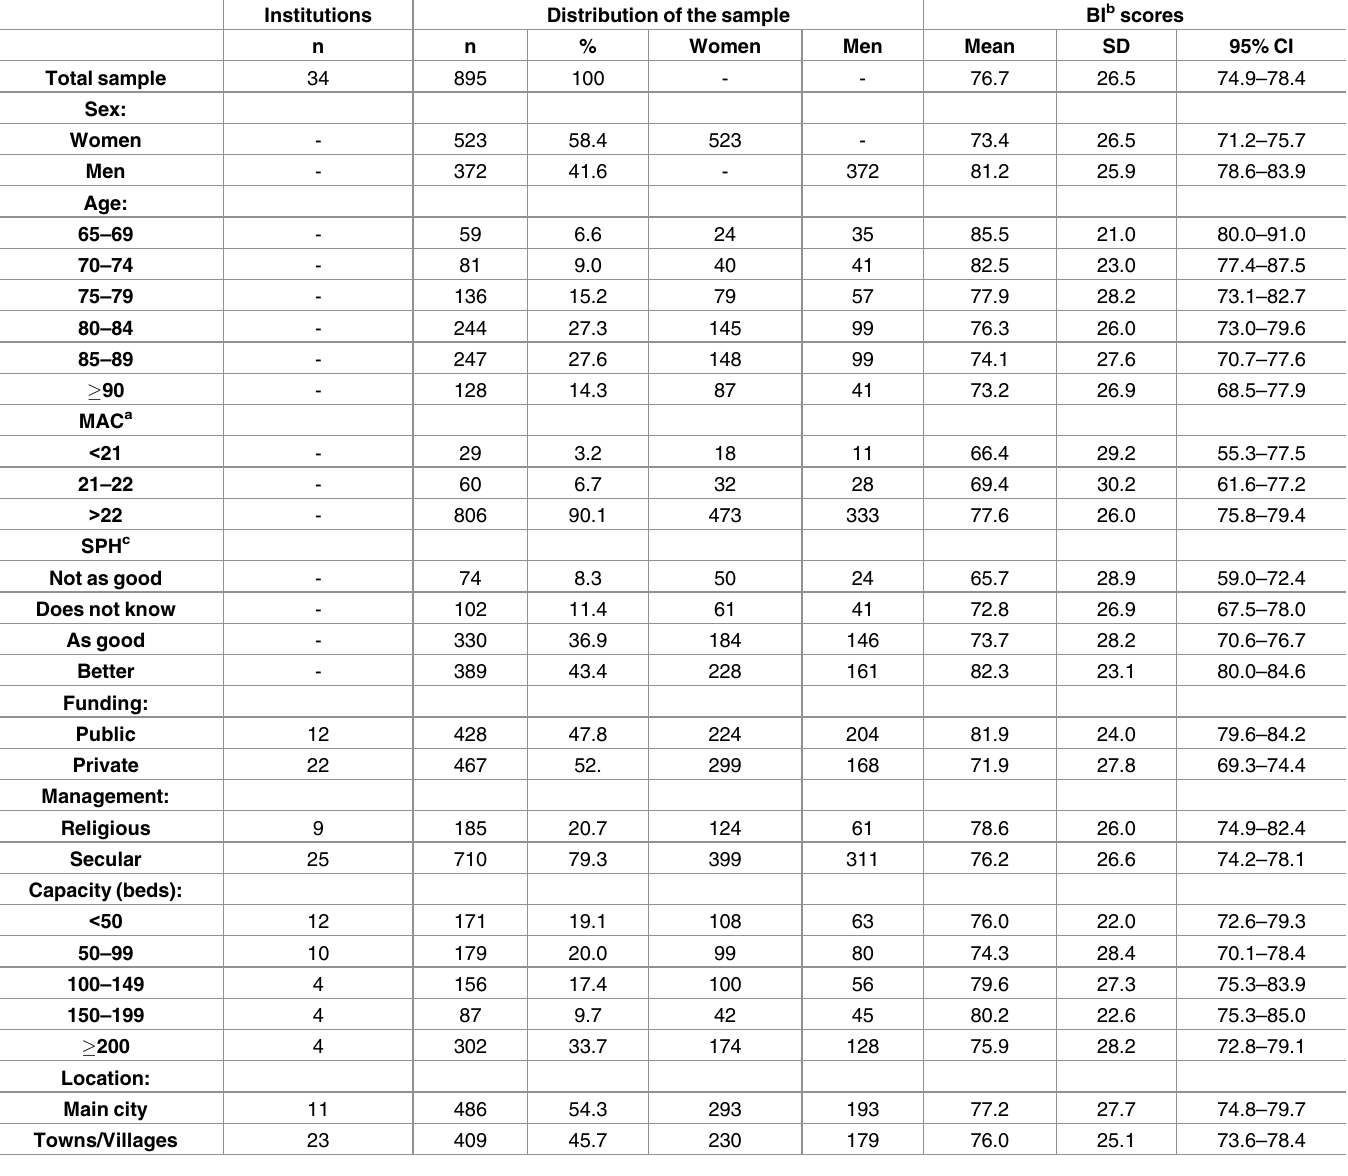
Table 1. Distribution of the elderly population participating in the survey and distribution of BI scores. Institutions Distribution of the